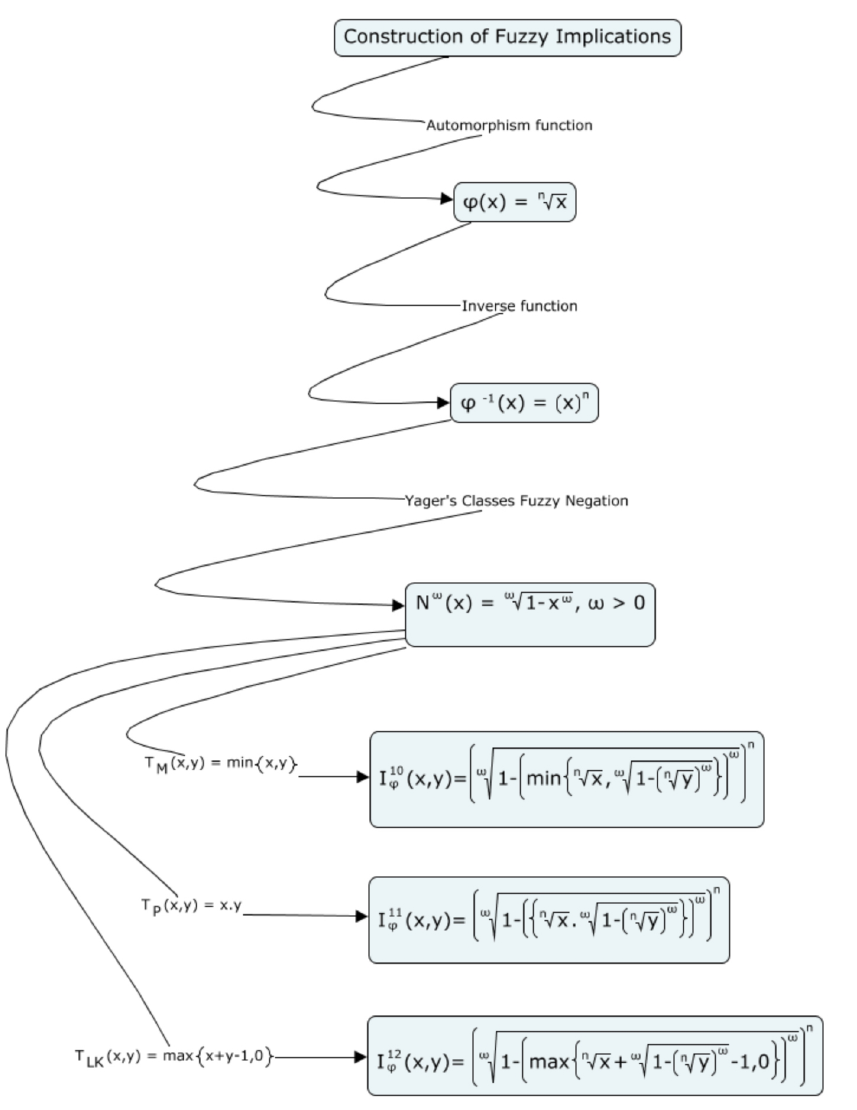
√ √ x , N ω ( x ) = ω 1 − x ω ,